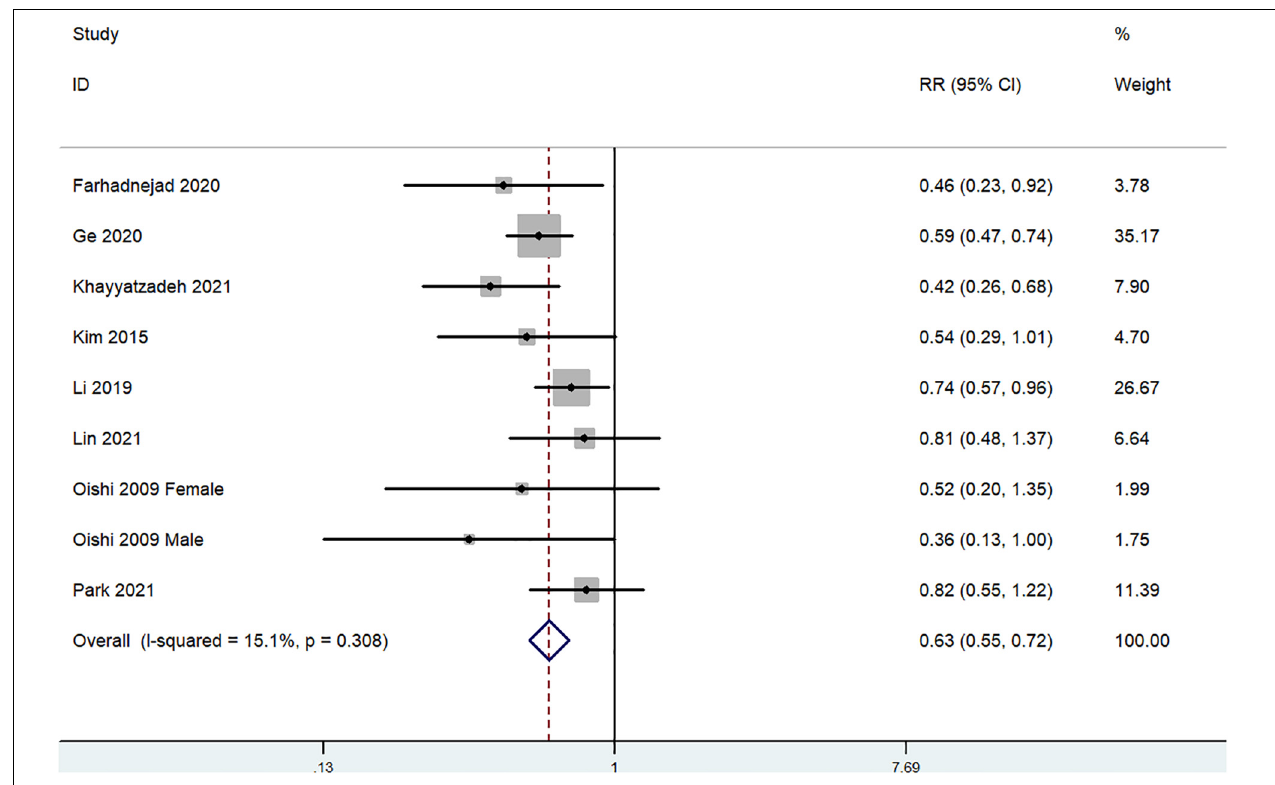
FIGURE 4 | Forest plot of meta-analysis: Overall multi-variable adjusted RR of depression for the highest vs. lowest category of dietary beta-carotene intake.